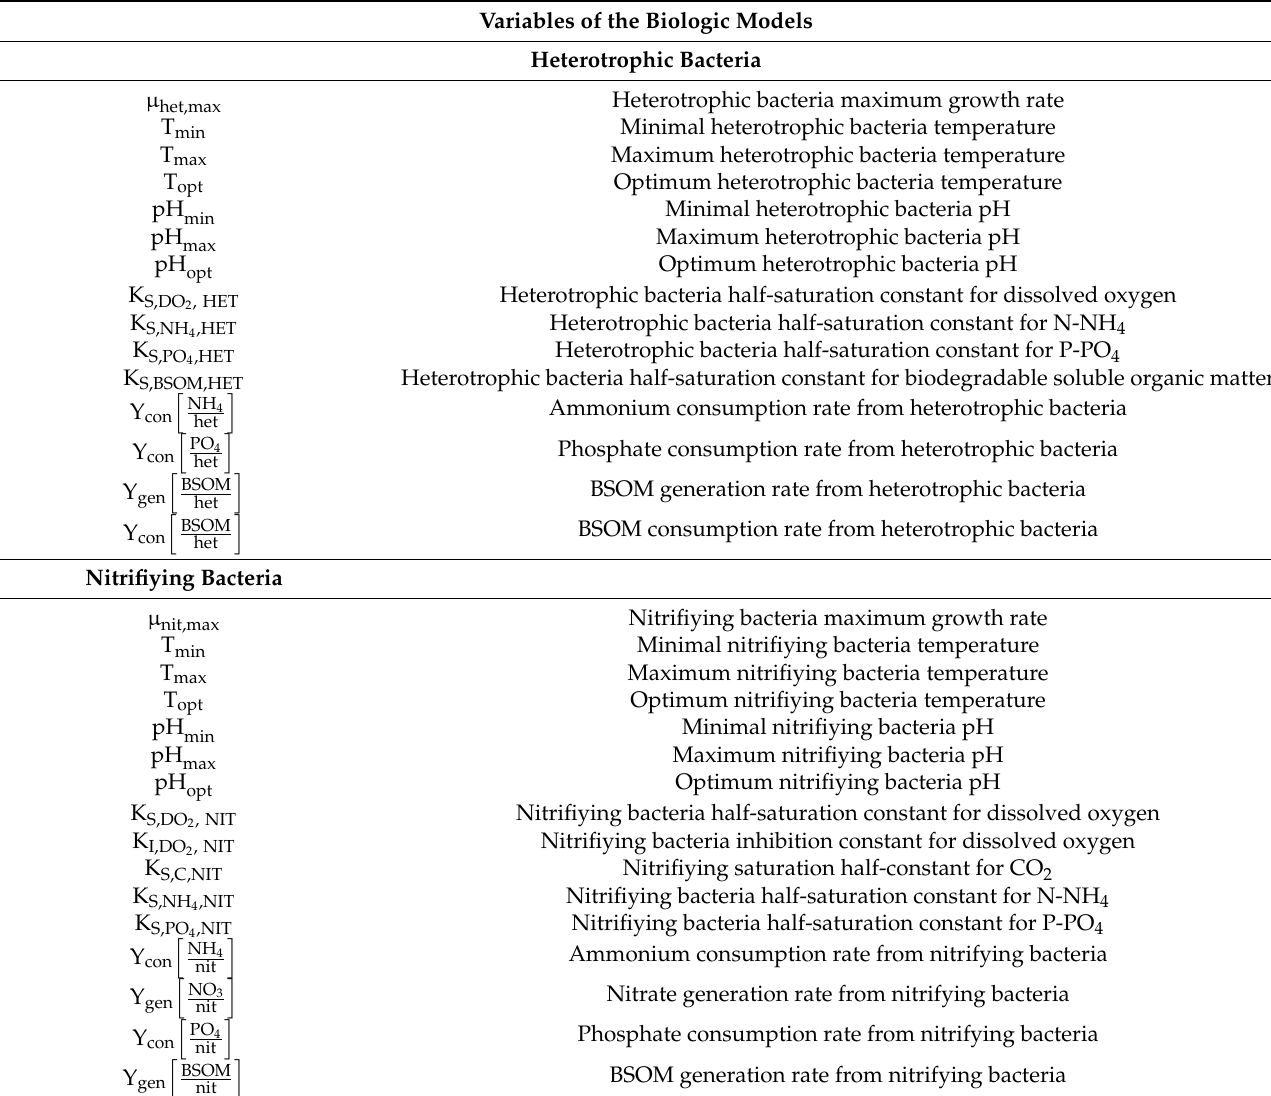
Table A1. Variables for the proposed ABACO